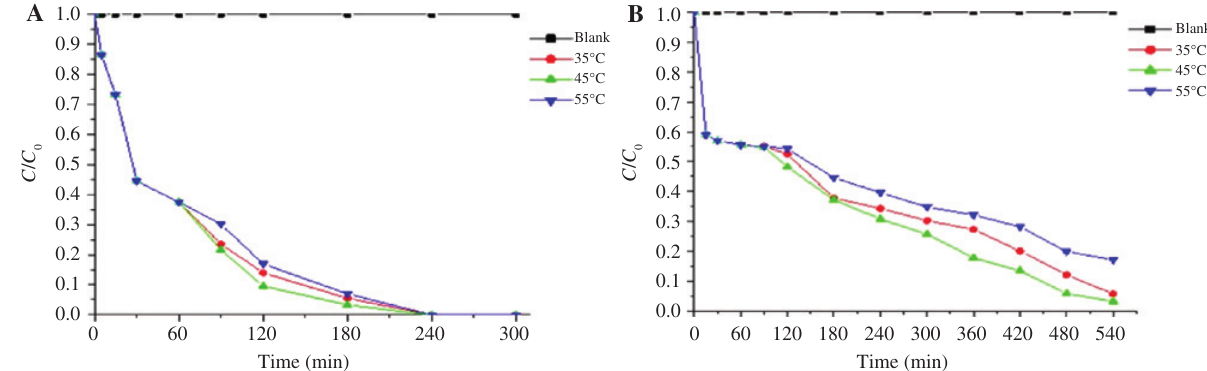
Figure 11: Effect of temperature on the decolorization of (A) reactive black 5 and (B) methylene blue